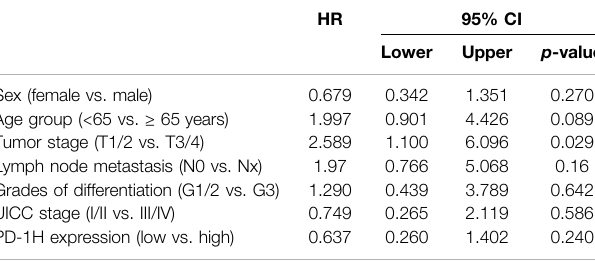
TABLE3| Multivariateanalysesforthepredictionofoverallsurvivalinpatientswith